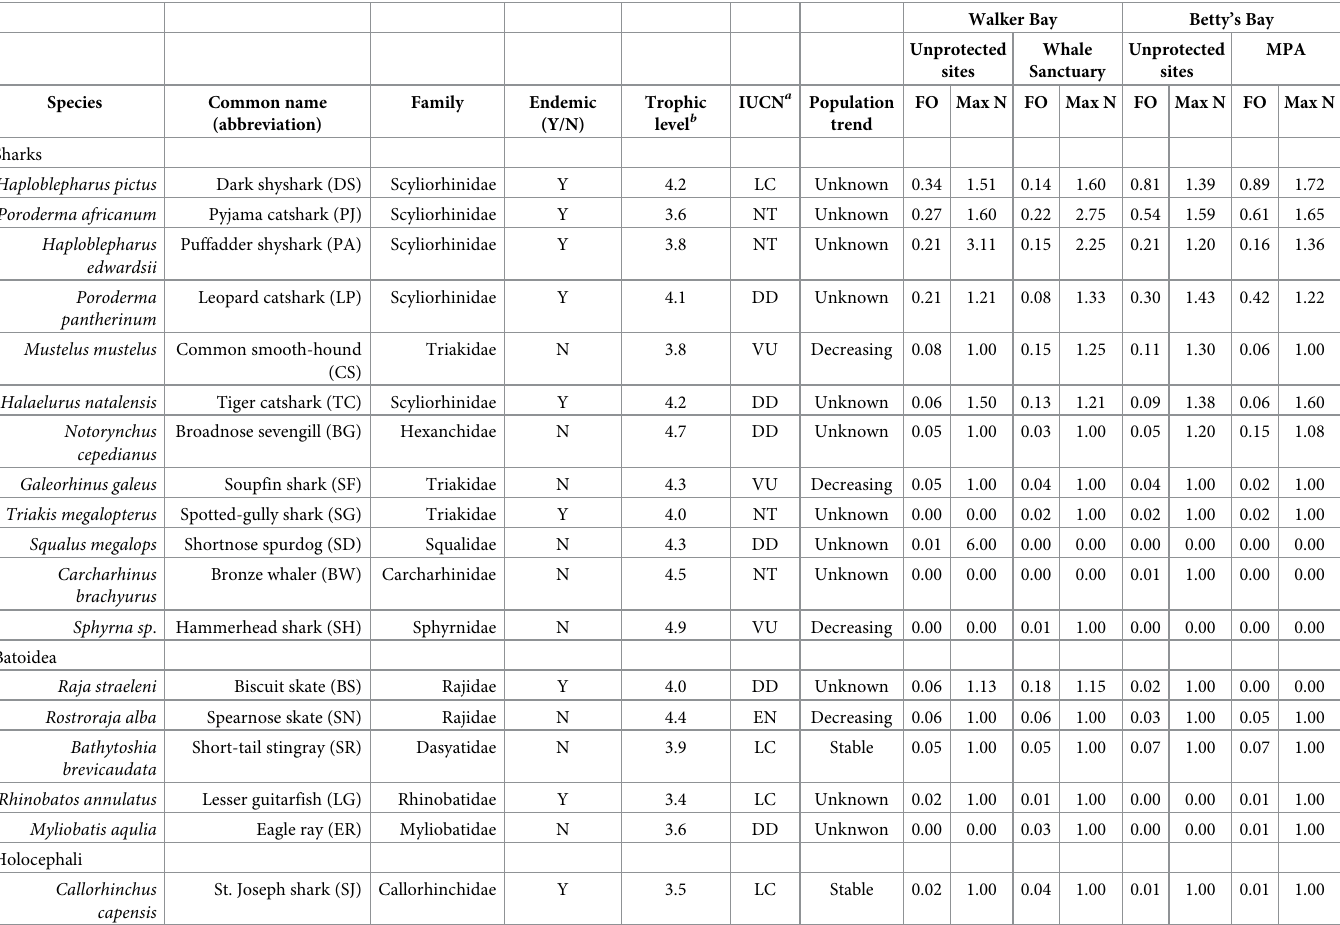
Table 1. Summary of the taxonomy, endemism, IUCN Red List status, population trend on the IUCN Red List (Version 2019–2), trophic level, and relative abun- dance (FO, MaxN) a of the chondrichthyan species observed on BRUVs, ordered from highest to lowest FO within each taxonomic group (Sharks, Batoidea, Holocephali).